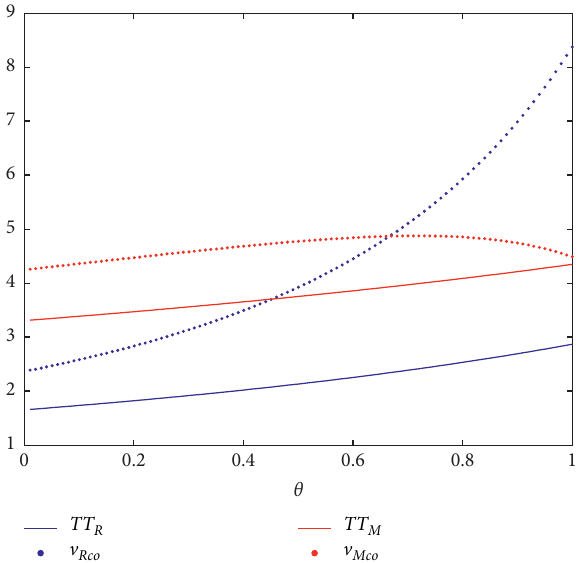
Figure 4: Optimal CSR results between decentralized and cen- tralized decisions when ρ